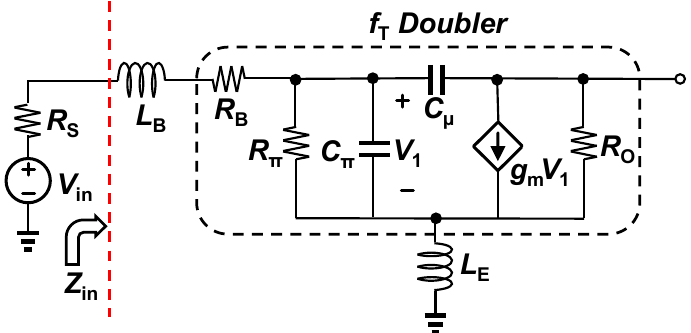
Figure 2. Equivalent small-signal model of the proposed TSV-integrated RF f T -doubler amplifier.